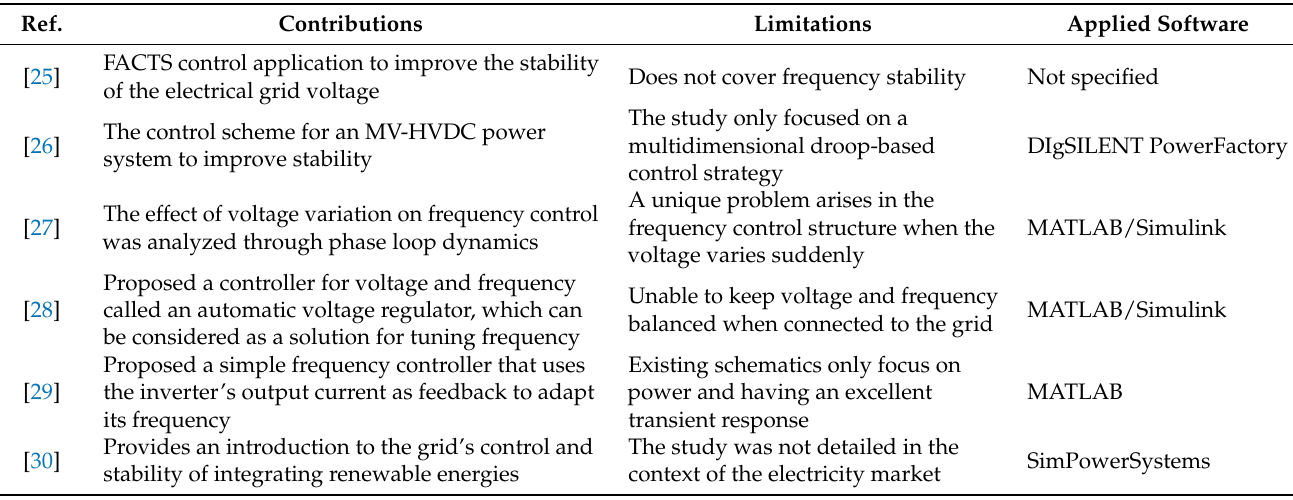
Table 1. Studies of voltage and frequency stability in electrical power systems.